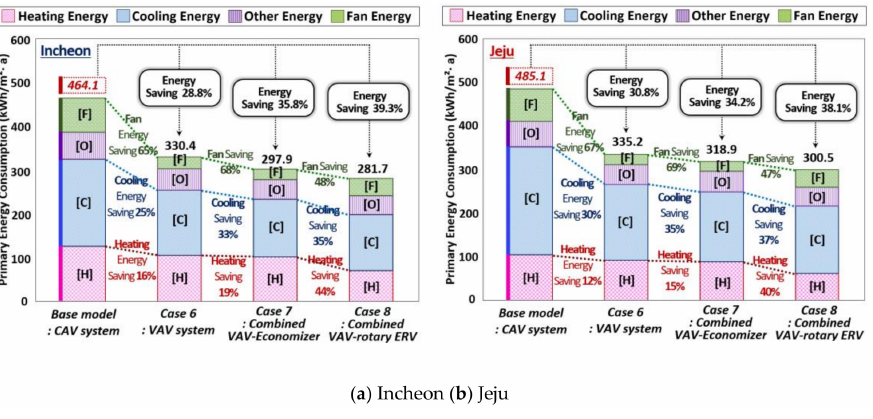
Figure 14. Primary energy consumptions and energy saving potential (%) of Case 7 and Case